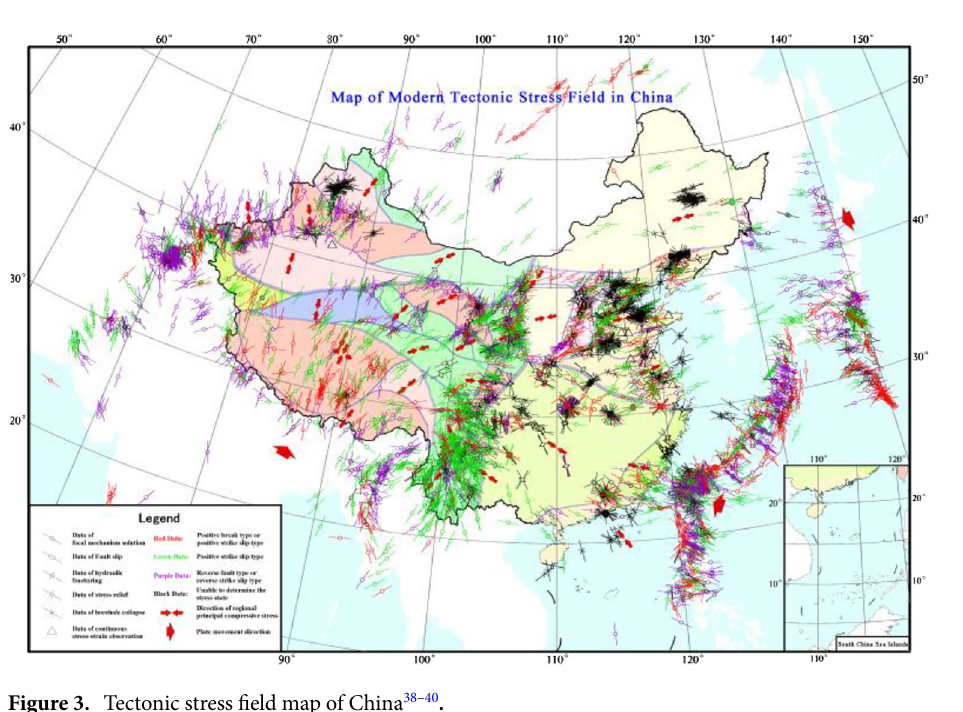
Figure 3. Tectonic stress field map of China 38–40